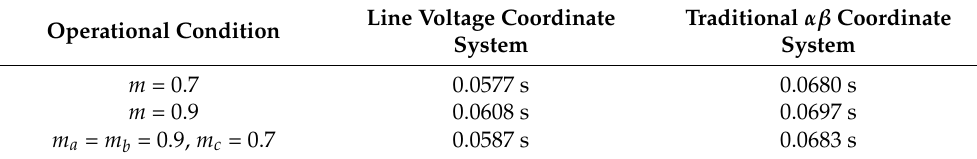
Table 6. Computing time.